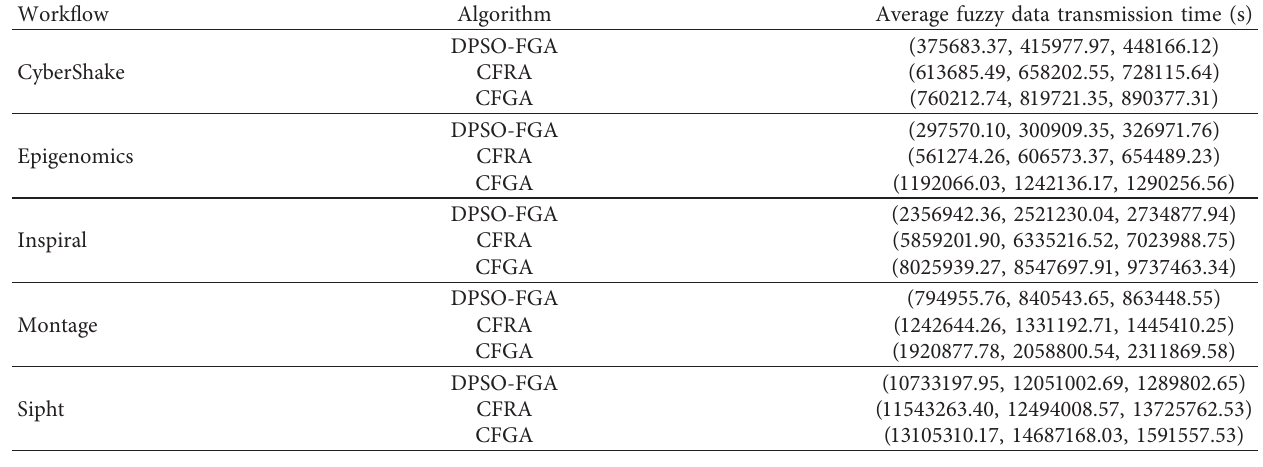
Table 2: Average fuzzy data transmission time of different algorithms under various scientific workflows. Workflow